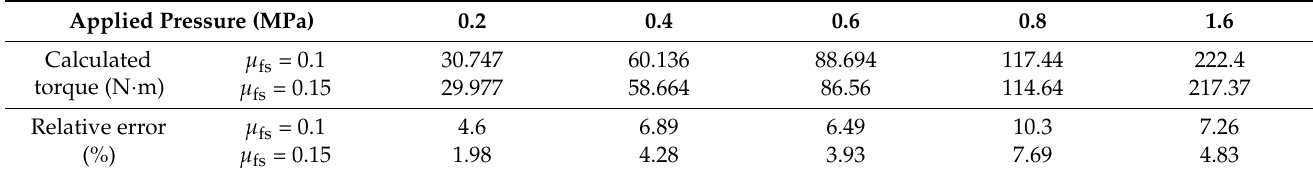
Table 3. Total calculated torque and relative